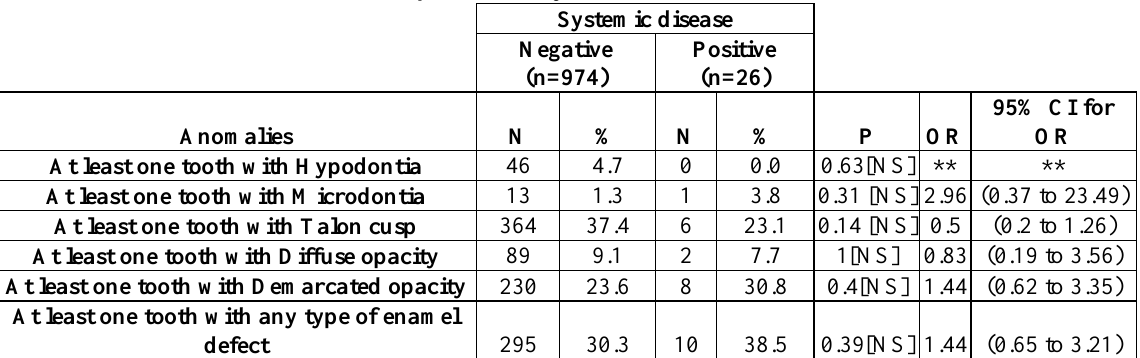
Systemic disease Negative Positive (n=974) (n=26)